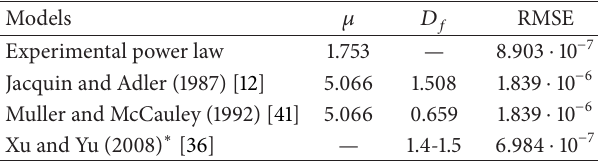
Table 1: Main parameter values of the fractal models analyzed.